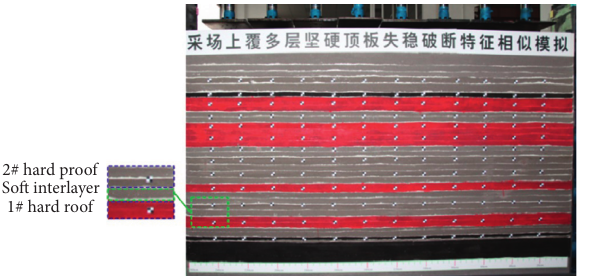
Figure 4: Similar material model of 8101 working face.